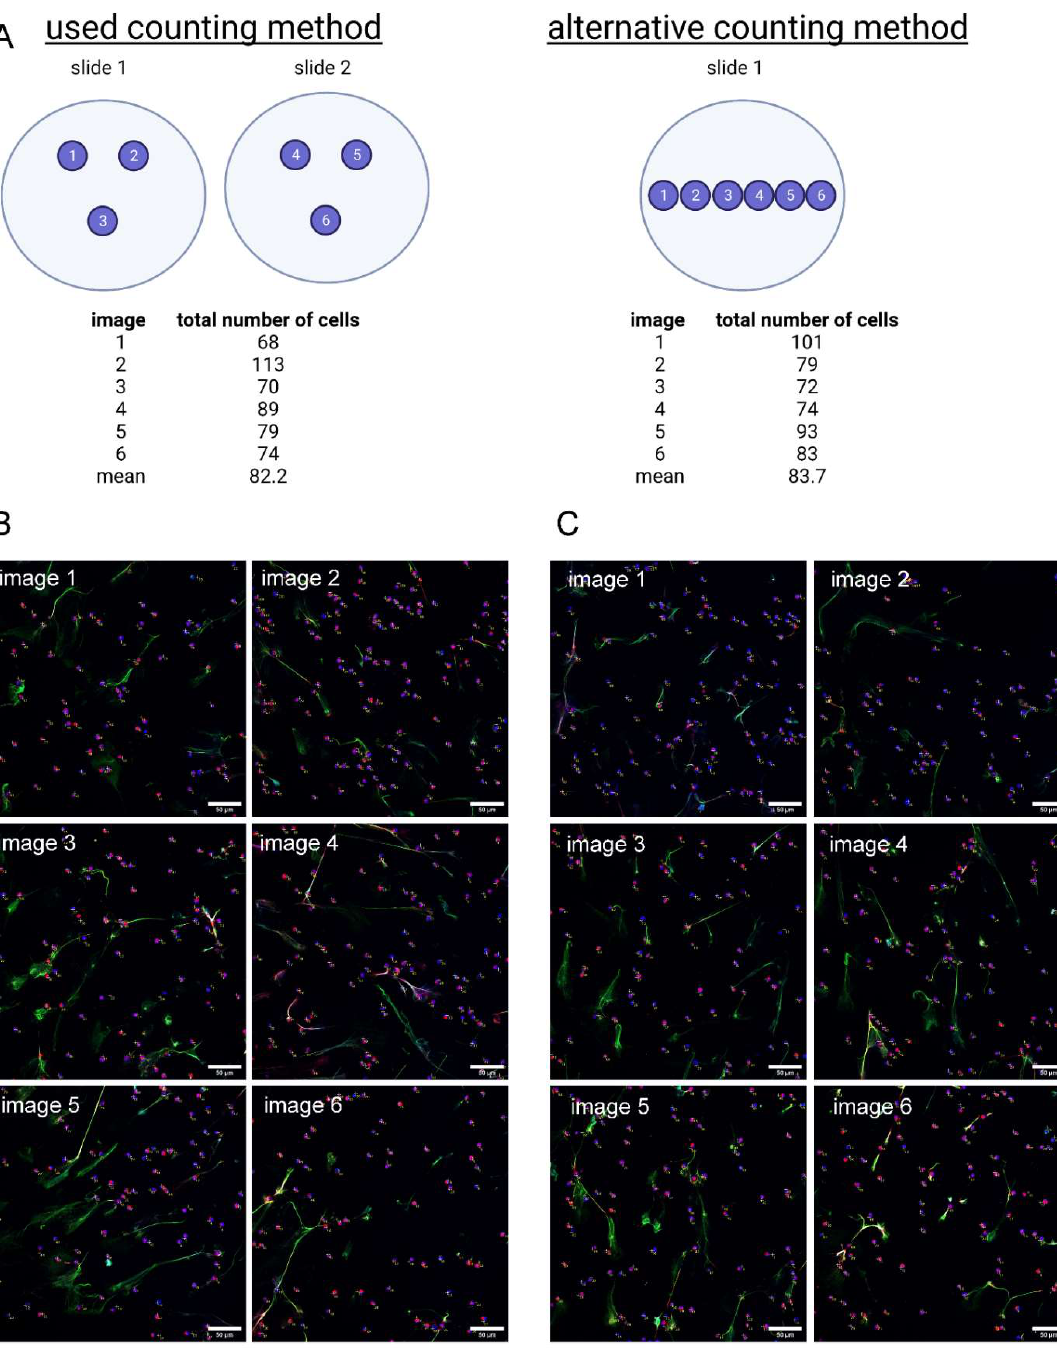
Figure A4. Representative immunofluorescence images (overlay) of NET induction assays after incubation with CD (positive control). Staining: blue = DNA; green = DNA/histone-1-complexes; red = myeloperoxidase. ( A ) Representative overview of the positions where the images of the used counting method and the alternative counting method were taken. ( B ) Six pictures were taken on two slides at predefined positions (1–6); ( C ) Six pictures were taken on one slide per row at the center of the slide (1–6). All settings were adjusted to respective isotype controls. In all six images, the total amount of cells was counted using ImageJ cell counter. Each counted cell is marked with a yellow cross and a number. The total number per image as well as the mean of six images are presented. Both counting methods reflect a comparable number of cells in the six pictures. In this study, all samples were analyzed with the method presented in A .